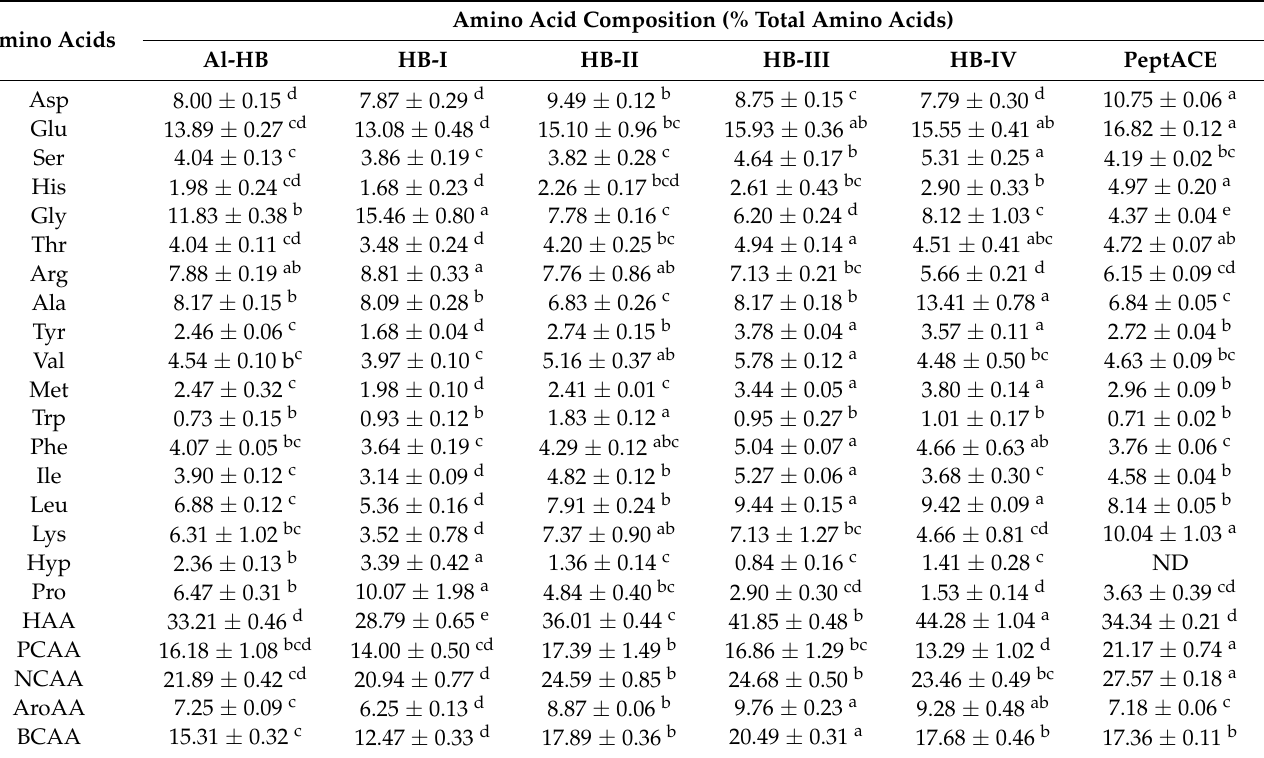
Table 2. Amino acid composition (expressed as % of total amino acids) of Al-HB and its peptide